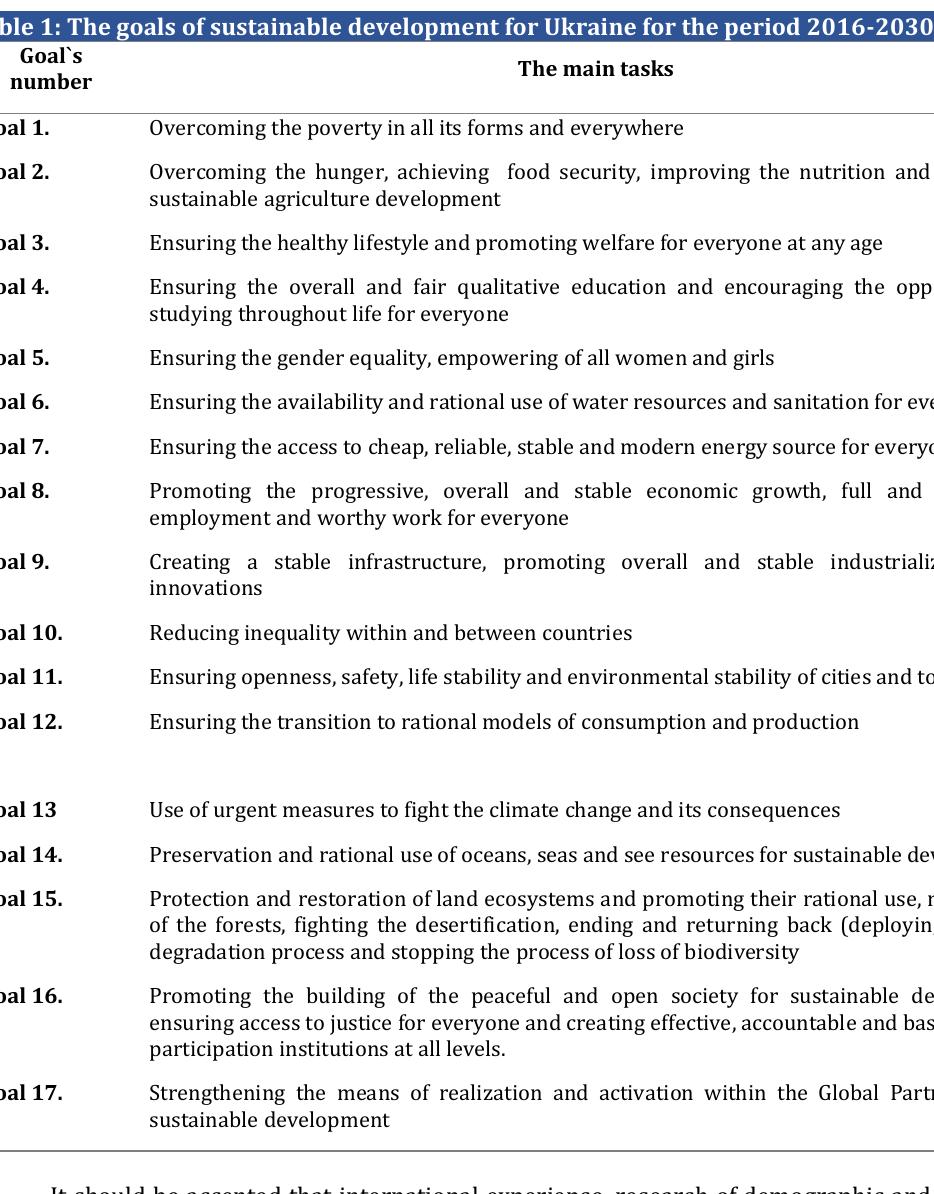
Table 1: The goals of sustainable development for Ukraine for the period 2016-2030 Goal`s number